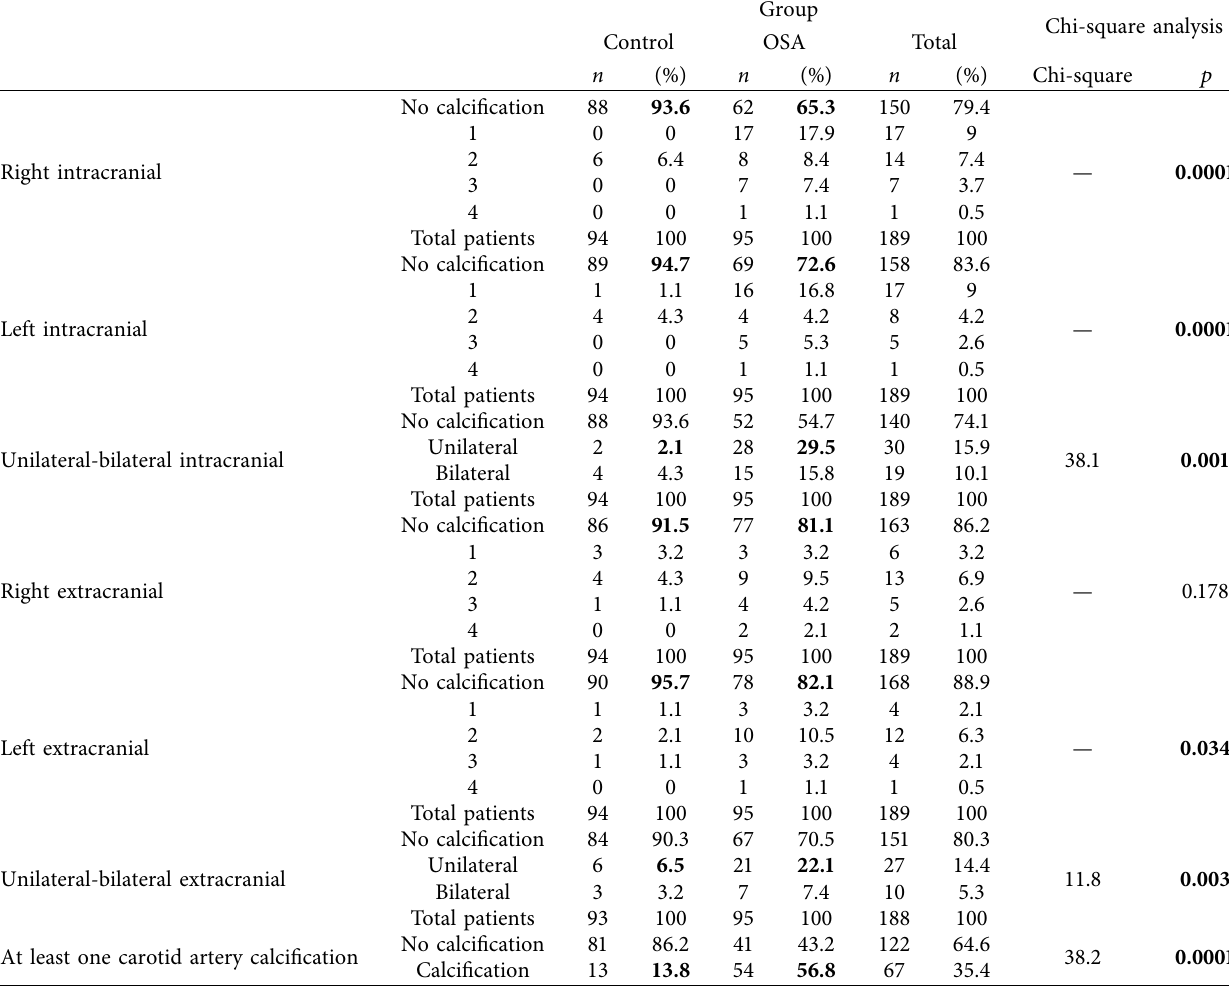
Table 3: Comparison of extra and intracranial carotid artery calcifications between OSA and control